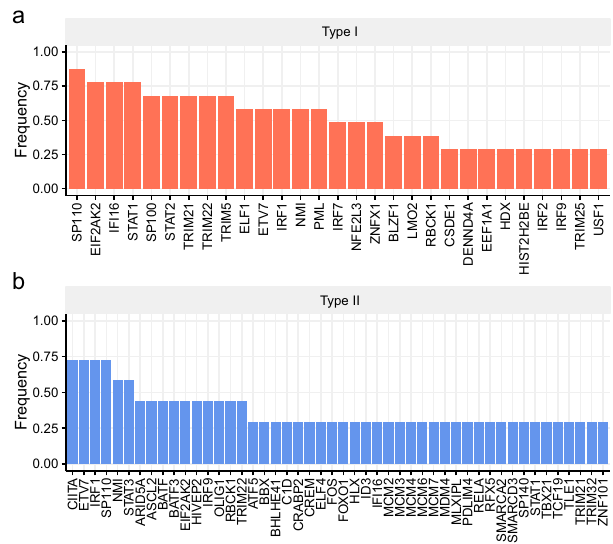
Fig. 4 The genes consistently identi fi ed as key regulators. Key regulators in (a) type I interferon stimulation and (b) type II interferon stimulation datasets. The full list has been shown in Table 2. The top 35 regulators in each dataset were included as key regulators, and only the regulators identi fi ed in more than 25% of datasets were